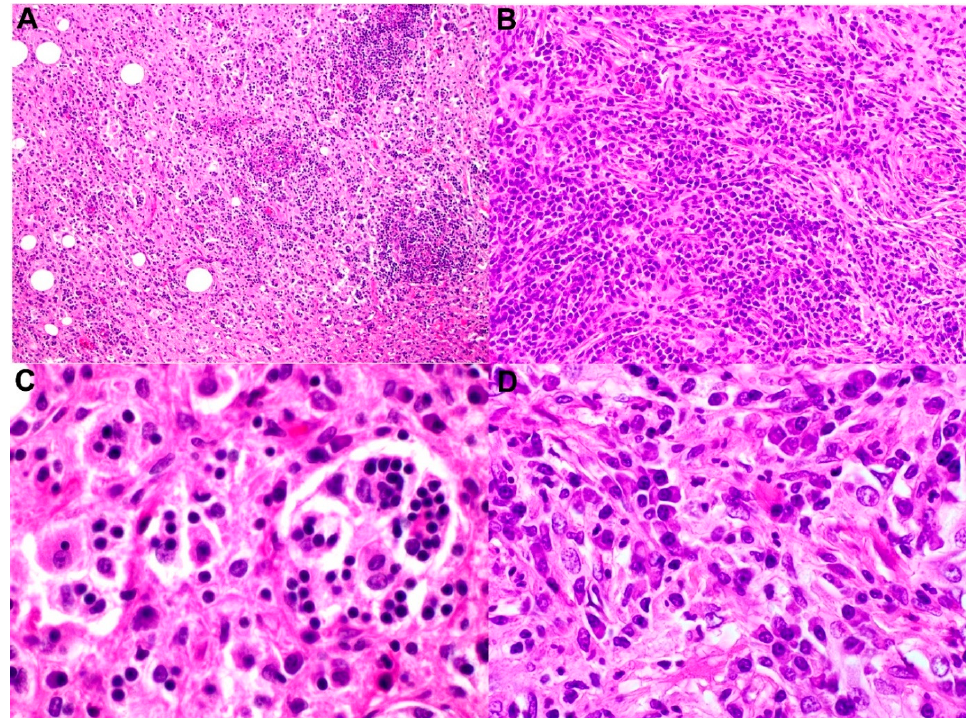
Figure 1. The selected images show a case of nodal Rosai–Dorfman disease with concurrent IgG4 ‐ related disease. ( A ) Low ‐ power magnification shows effacement of normal lymph ‐ node architecture by histiocytes (H & E, magnification 40×). ( B ) Higher ‐ power magnification demonstrates increased plasma cells arranged in nests and singly associated with background fibrosis and histiocytes (im ‐ munoperoxidase, magnification 200×). ( C ) Loaded histiocytes with emperipolesis and ( D ) an in ‐ creased number of plasma cells (immunoperoxidase, magnification 600× and 600×, respectively). Fine ‐ needle aspiration–smears and touch imprints are typically highly cellular with many histiocytes and engulfed lymphocytes (emperipolesis) against a background of mixed inflammatory cells, including plasma cells and lymphocytes. Histiocytes tend to be large with abundant cytoplasm and a round, vesicular nucleus with a small central nucle ‐ olus. In smear and imprint preparations, there tends to be a diagnostic dilemma; overlap ‐ ping lymphocytes can be mistaken for emperipolesis as engulfed lymphocytes do not ap ‐ pear surrounded by a halo, as seen in tissue sections. In later stages of RDD, there tends to be increased plasma cells and cytoplasmic immunoglobulin inclusion (Russell bodies). Studies have shown that RDD histiocytes express CD4, CD11c, CD14, CD68 (KP ‐ 1), and CD163 [33–35]. Uniquely, in RDD, the histiocytes express S100, which is a useful fea ‐ ture for visualizing the emperipolesis, as first described in a single case by Aoyama et al. [36] and confirmed in a larger series by Miettinen et al. [37] (see Figure 2). RDD is usually negative for pan B ‐ or T ‐ cell antigens, markers for Langerhans cells (CD1a and langerin/CD207), and follicular dendritic cell markers (CD21, CD23, CD35, and clusterin). RDD histiocytes are also reactive to α 1 ‐ antichymotrypsin and α 1 ‐ antitrypsin, which might suggest lysosomal activity.